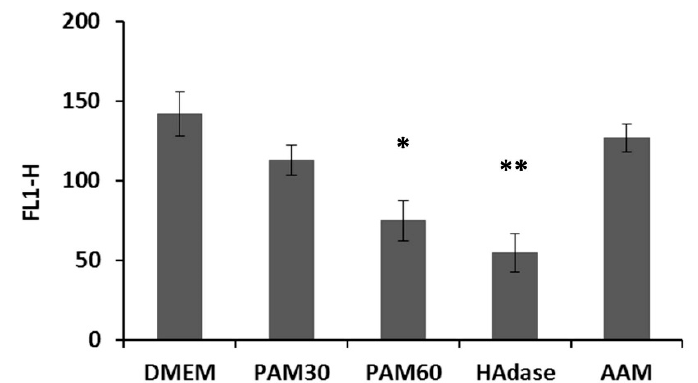
Figure 1. Flow cytometry determination of the hyaluronan (HA) expression in non-adherent HaCaT cells after cultivation in plasma-activated media (PAM) or control media for 3 h. Note that the fluorescence intensity for HA was reduced depending on the plasma treatment time used for generation of the PAM (mean ± s.e.m., n = 3, unpaired t -test, * p < 0.05, ** p < 0.01). Abbr.: FL1-H: fluorescence intensity, DMEM: Dulbecco’s modified Eagle’s medium, PAM30: 30 s plasma-treated DMEM, PAM60: 60 s plasma-treated DMEM, AAM: 60 s argon gas-treated DMEM, HAdase: DMEM with hyaluronidase.